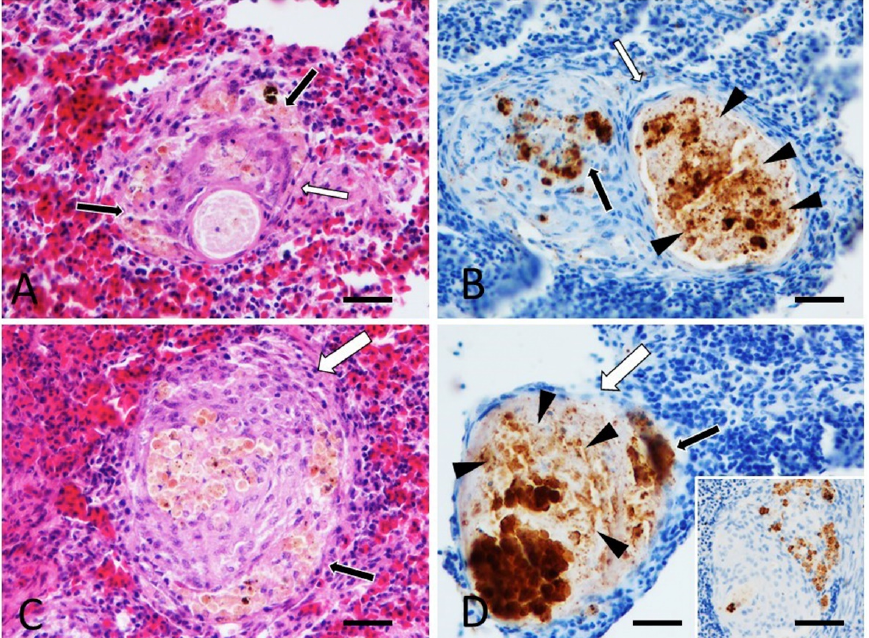
Figure 4. Cases 1 ( A , B ) ( A. jacobfreibergi ) and 5 ( C , D ) ( M. estherae ). Spleen. Comparison between H&E (( A , C ) bar 100 µ m) and IHC (( B , D ) bar 100 µ m) of MMC and granulomas labelling PAB antibody. ( A , C ) Development of granulomas within MMC. ( B , D ) IHC signal associated with macrophages of MMC (black arrows) and granular and specific immunoreactivity (arrowheads) within granulo- mas (white arrows) arising inside the MMC. Inset: negative control. MMC at upper right shows an aspecific signal, the granuloma in the center does not show staining (inset: bar 300 µ